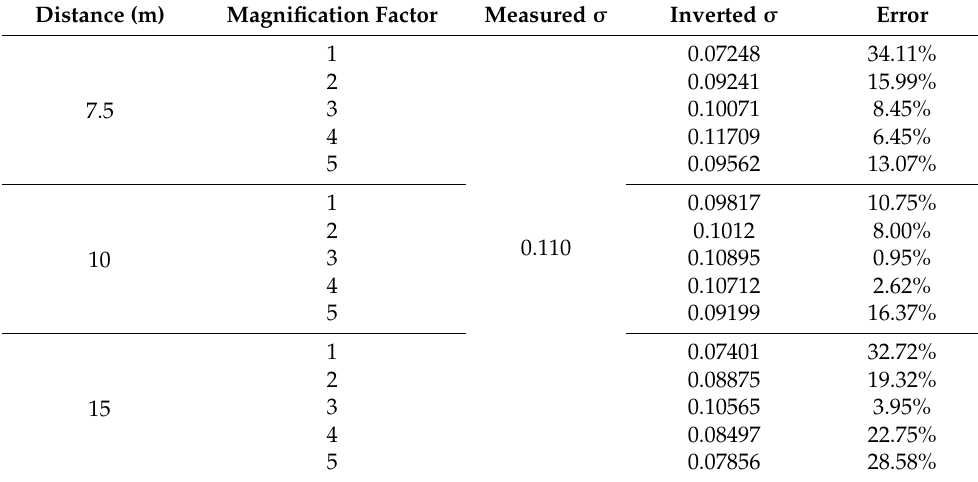
Table 3. Inverted σ of target